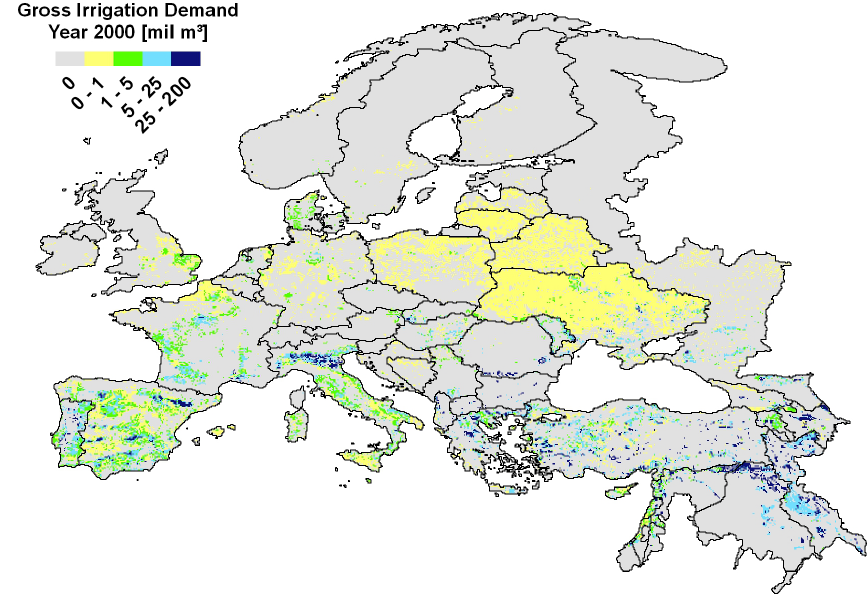
Fig. 3. Gross irrigation water requirements for the year 2000, as modelled with WaterGAP3. Figure 3: Gross irrigation water requirements for the year 2000, as modelled with